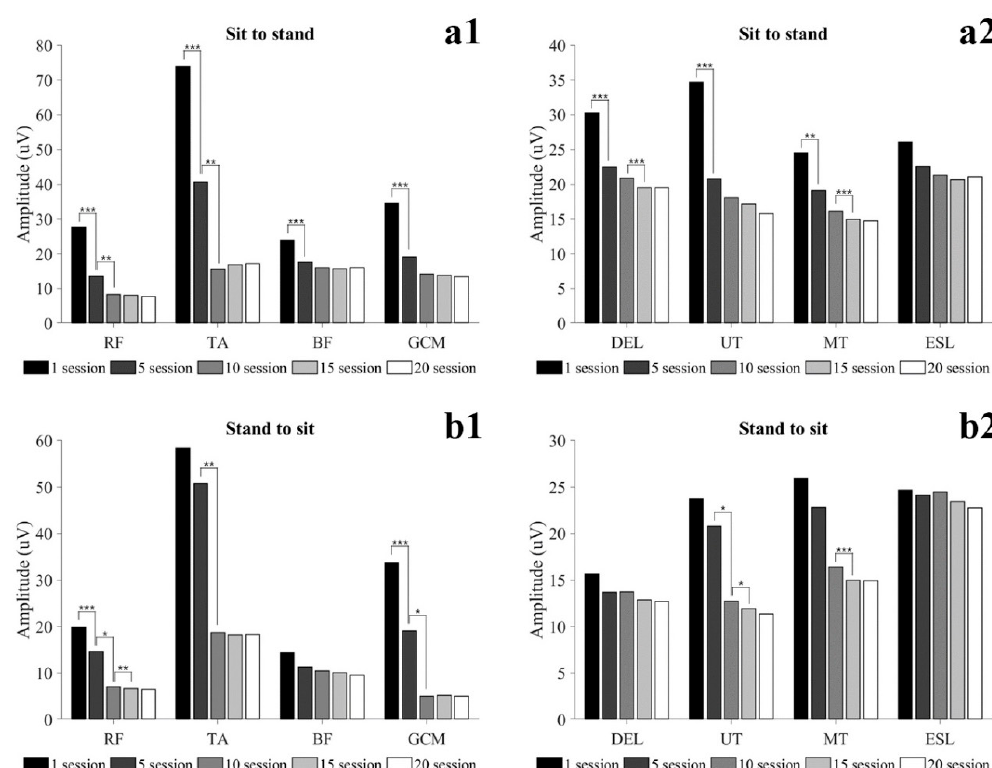
Figure 3. Changes in muscle activity in dynamic condition during locomotion training. ( a1 ). sit to stand (lower extremity muscles). ( a2 ). sit to stand (trunk and shoulder muscles). ( b1 ). stand to sit (lower extremity muscles). ( b2 ). stand to sit (trunk and shoulder muscles); * = p < 0.05, ** = p < 0.01, *** = p < 0.001. Abbreviation: RF, rectus femoris; TA, tibialis anterior; BF, biceps femoris; GCM, gastrocnemius; DEL, deltoid; UT, upper trapezius; MT, middle trapezius; ESL, erector spine lumbar.